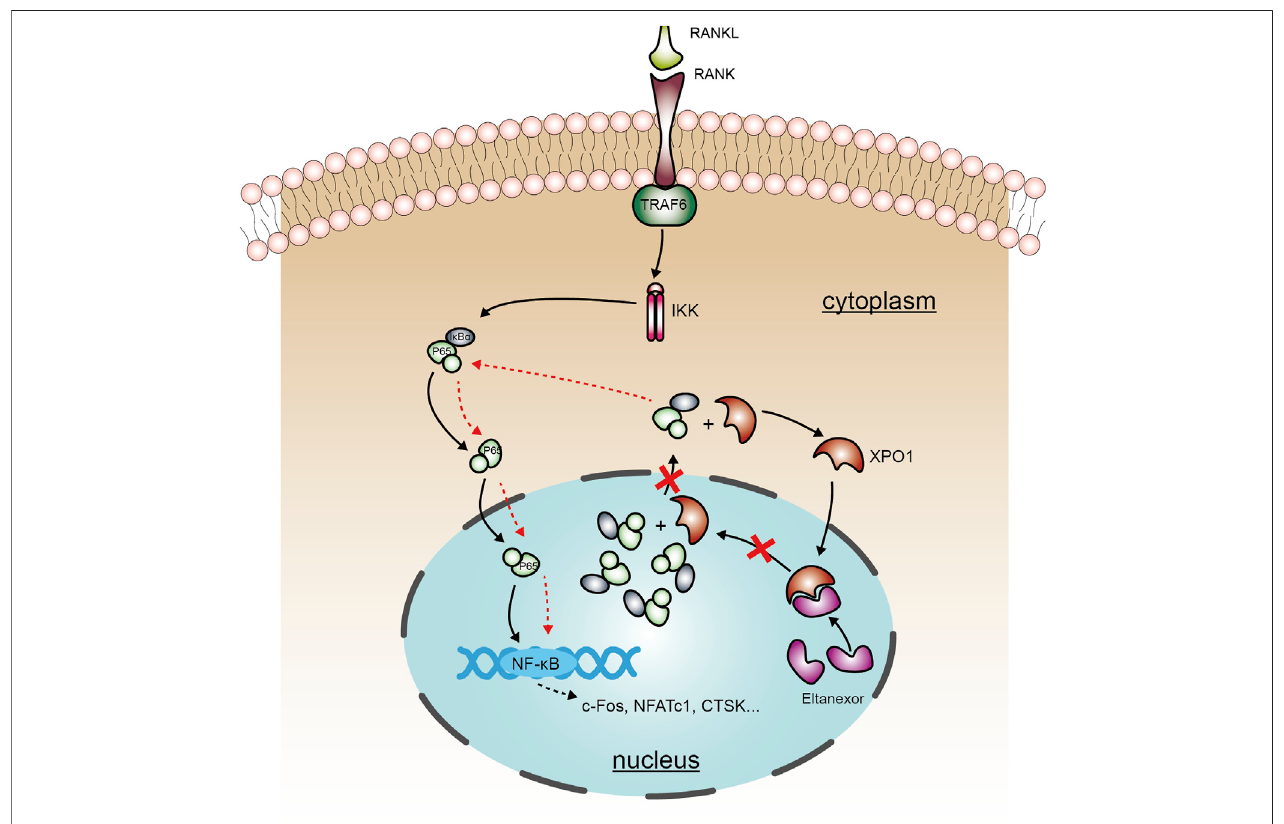
FIGURE7| AschematicdiagramshowingtheworkingmodeloftheroleofEltininhibitingosteoclastogenesis.EltinhibitstheNF- κ Bsignalingpathwayactivatedby RANKL in osteoclasts by blocking XPO1-dependent nucleus-to-cytoplasm transfer of NF- κ B, and this effect strengthens the mechanism of inhibiting excessive activation of